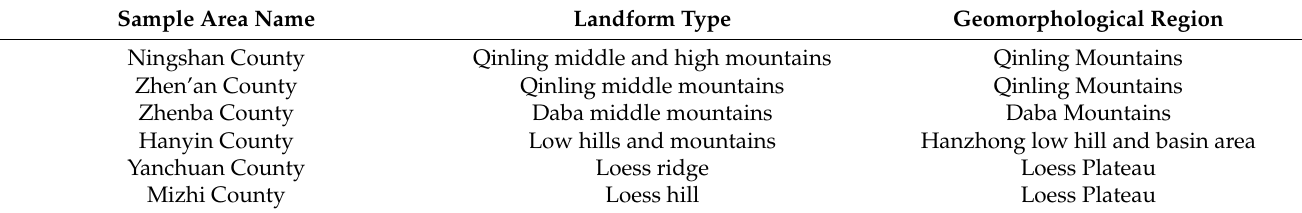
Table 1. Overview of the typical sample